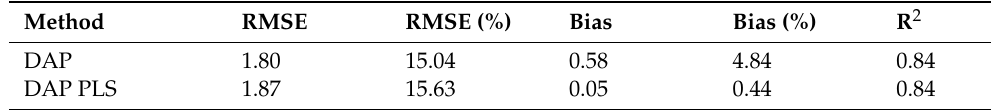
Table 7. Statistics comparing the HP 95 metric (95th percentile) obtained by DAP and DAP-DTM LiDAR and the dominant heights of the plots obtained by the TFI.